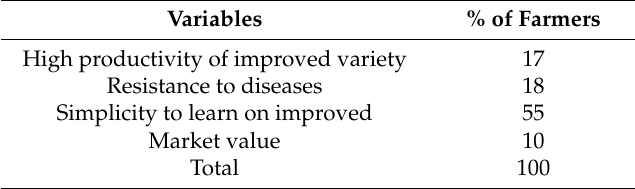
Table 3. Features of the innovation (improved varieties) based on farmer views ( n = 300).